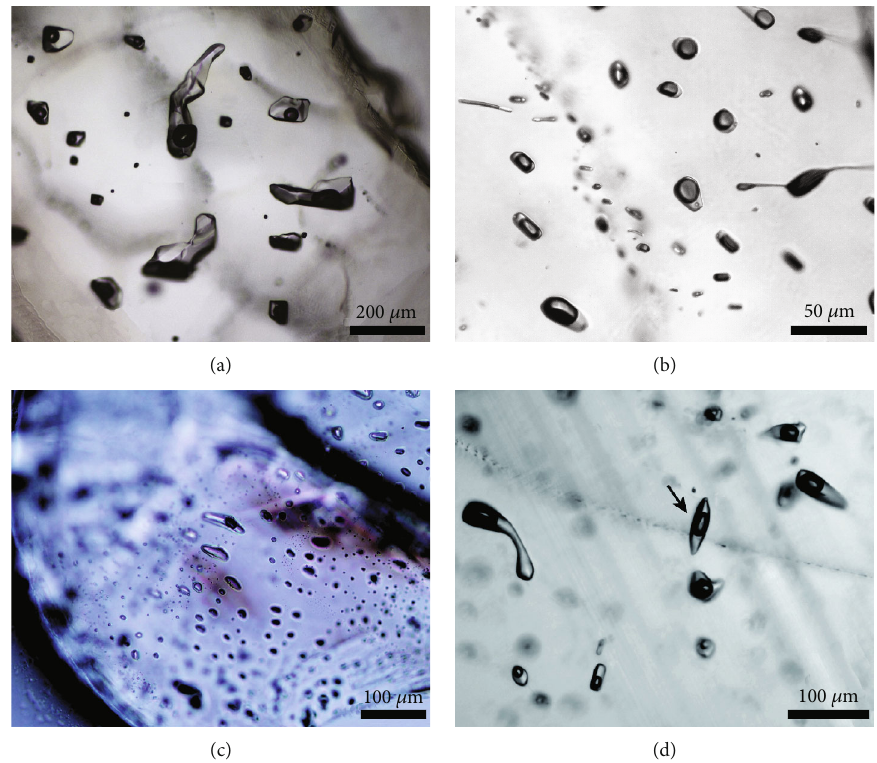
Figure 2: Microscopic photographs of the synthetic fl uid inclusions with di ff erent FIS techniques. (a) Fluid inclusions synthesized by a composite method combining the thermal shock with alkali etching, cited from Zhou et al. [71]; (b) fl uid inclusions synthesized by in situ fracturing FIS technique with rapid-quench autoclave, cited from [69]; (c) secondary fl uid inclusions synthesized by in situ fracturing FIS technique with piston cylinders, cited from Tsay et al. [79]; (d) a large secondary fl uid inclusion (pointed by arrow) synthesized by in situ fracturing re fi lled FIS technique, cited from Li and Audétat